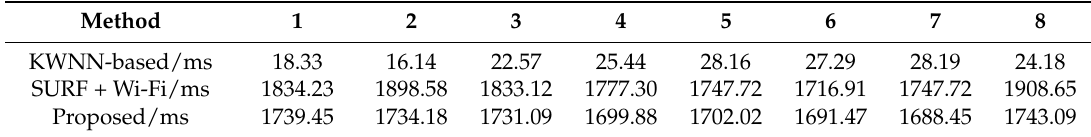
Table 5. Time-consuming comparison of different